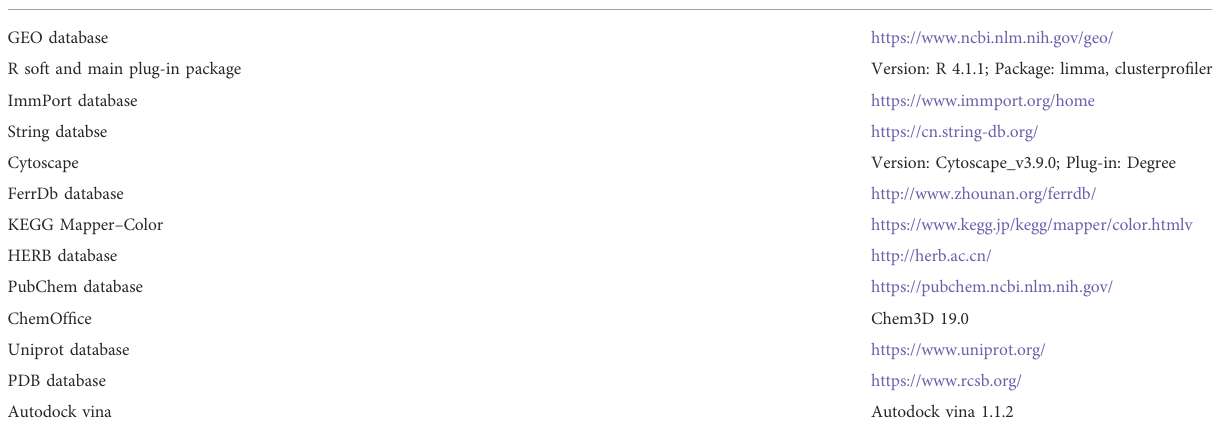
TABLE 2 List of all software and websites used in this